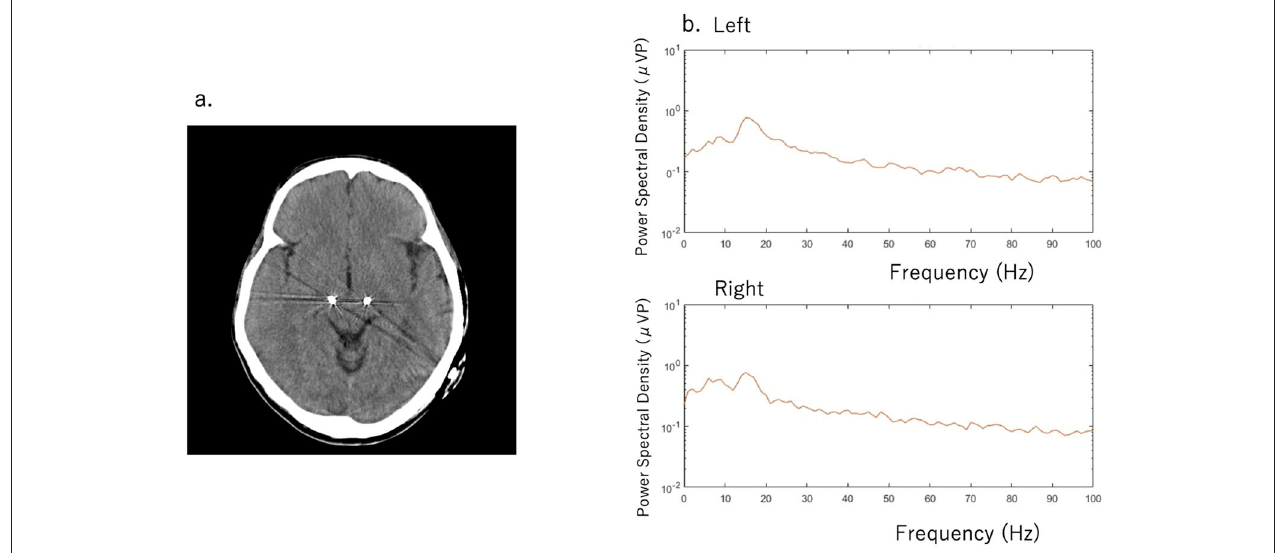
FIGURE 1 | (a) Computed tomography scan with deep brain stimulation (DBS) electrodes (b) Beta band oscillation was detected in the left subthalamic nucleus (STN) (16.6Hz with 1.20 µ Vp) and in the right STN (1.72 µ Vp) during the med-off/stim-off phase. The Movement Disorder Society revision of the United Parkinson’s Rating Scale (MDS-UPDRS) score was 27